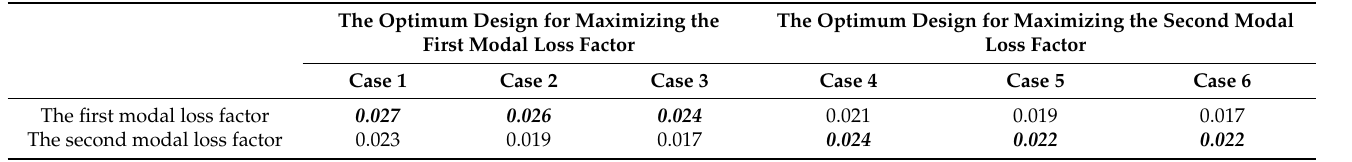
Table 6. The modal loss factors of the optimal designs (bold italics denote the modal loss factor of objective